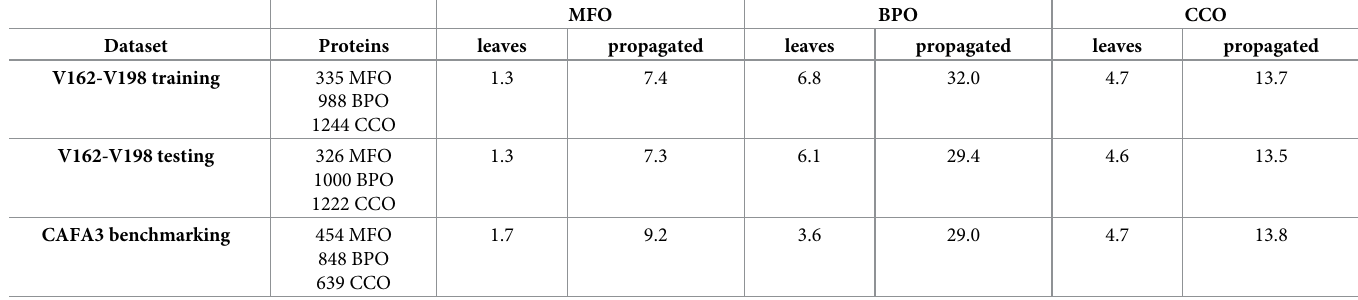
Table 1. Average GO terms per protein for the V162-V198 training and testing datasets and the CAFA3 benchmarking dataset. Molecular Function (MFO), Biologi- cal Process (BPO), and Cellular Component (CCO) ontologies; leaves: GO terms with no child terms annotated for the same protein; propagated: after propagating parent GO term annotations.